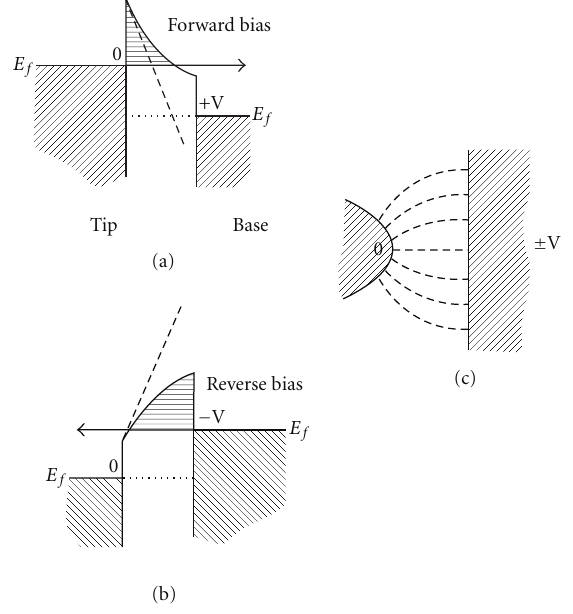
Figure 12: The (a) forward and (b) reverse asymmetric potential barriers for a geometrically asymmetric point-contact diode struc- ture. Figure taken from